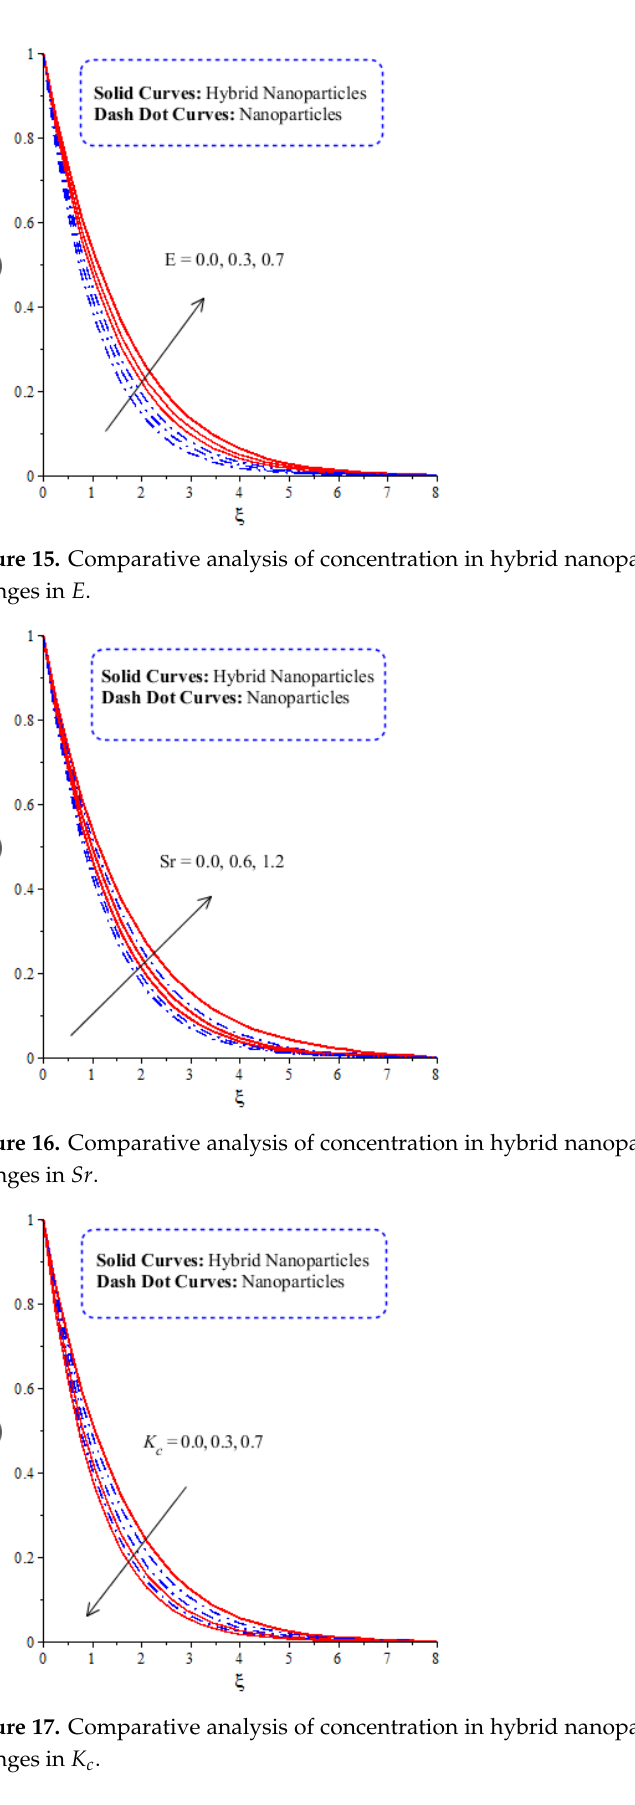
Figure 14. Comparative analysis of concentration in hybrid nanoparticles and nanoparticles with changes in 𝑆𝑐.